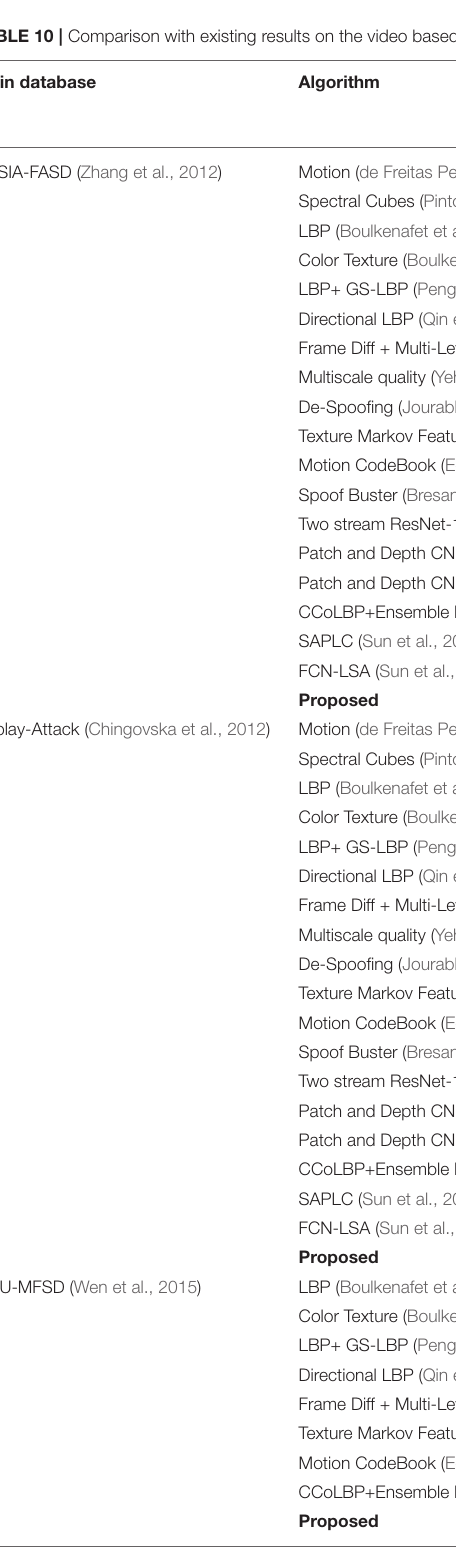
The results are reported in terms of average HTER (%). HTER of the cross database experiments and comparison with State-of-the-art results using video based countermeasure. Results of Spoof Buster (Bresan et al., 2019) are reported when a single database is used in training. (Top two results are bolded).